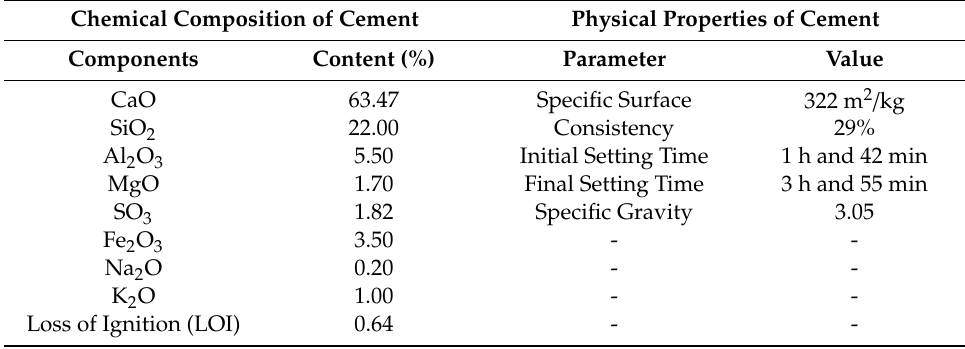
Table 1. Chemical composition (CC) and physical properties of Portland